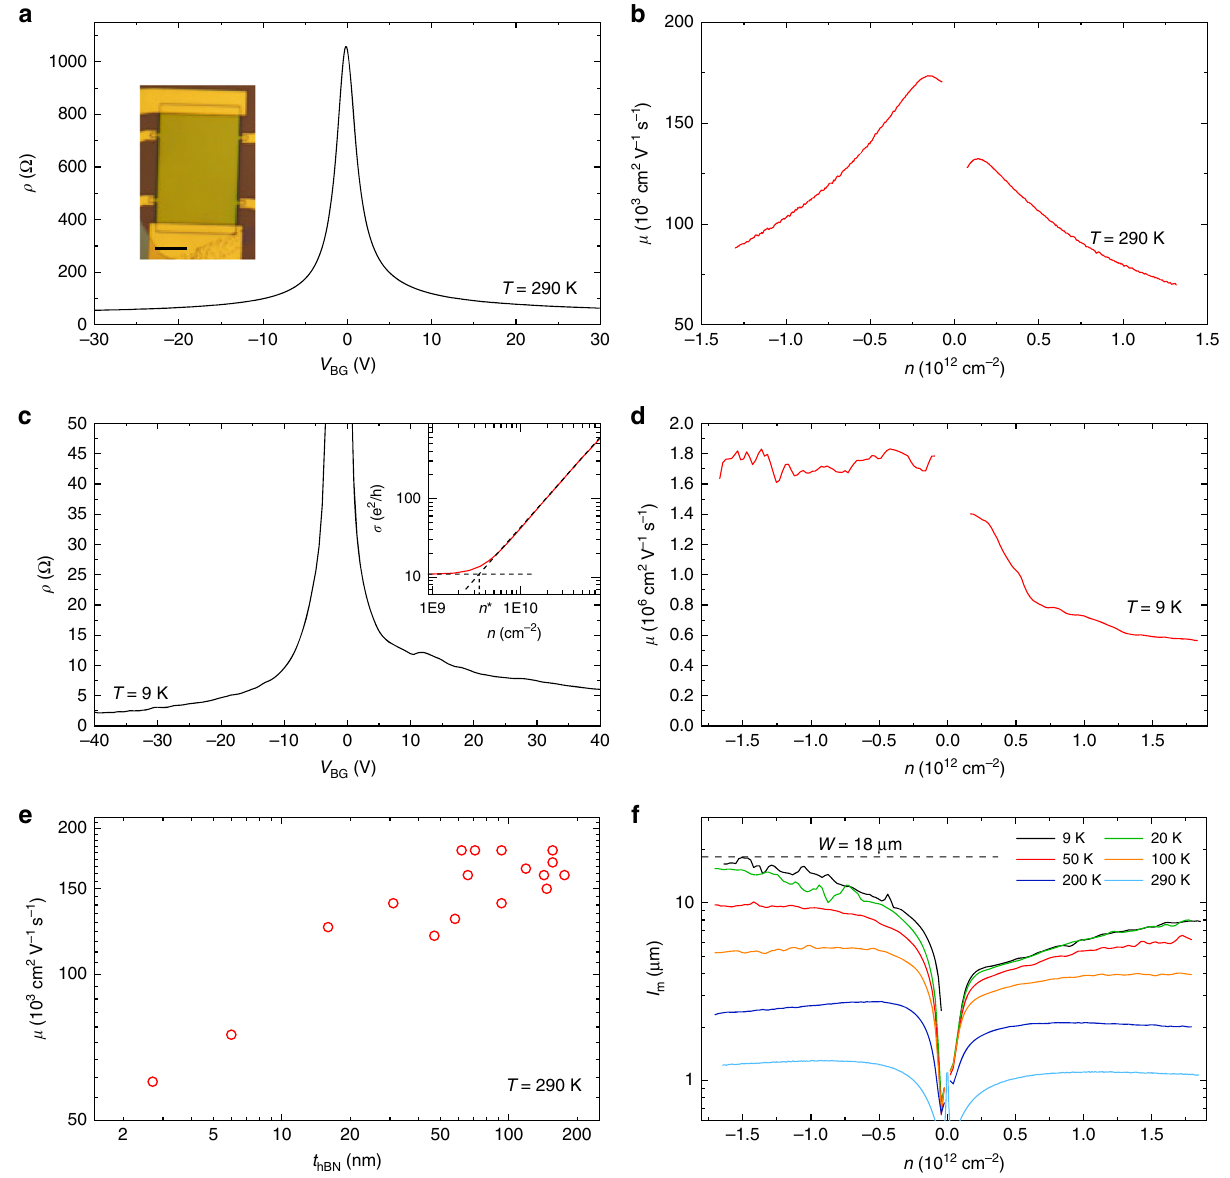
Fig. 7 Four terminal transport measurements. a Resistivity as a function of back gate voltage at room temperature. Inset: optical image of the measured Hall bar with W = 24 μ m. Scale bar 10 μ m. b Mobility μ = σ /( n e) at room temperature. n is extracted from a Hall measurement with a B = 0.5T out of plane magnetic fi eld. c Resistivity of the sample at 9 K. Inset: conductivity as a function of carrier density close to the CNP, showing the extraction of n * . The dashed lines represent extrapolated fi ts to the linear and sloped portions of the conductivity. d Extracted mobility as a function of charge carrier density at 9 K. e Room temperature mobility of 17 encapsulated SLG samples as a function of the bottom hBN thickness. The mobility is the peak value of the density dependent mobility, i.e., the mobility close to the CNP. f Mean free path as a function of carrier density for different temperatures for a sample with width W = 18 μ